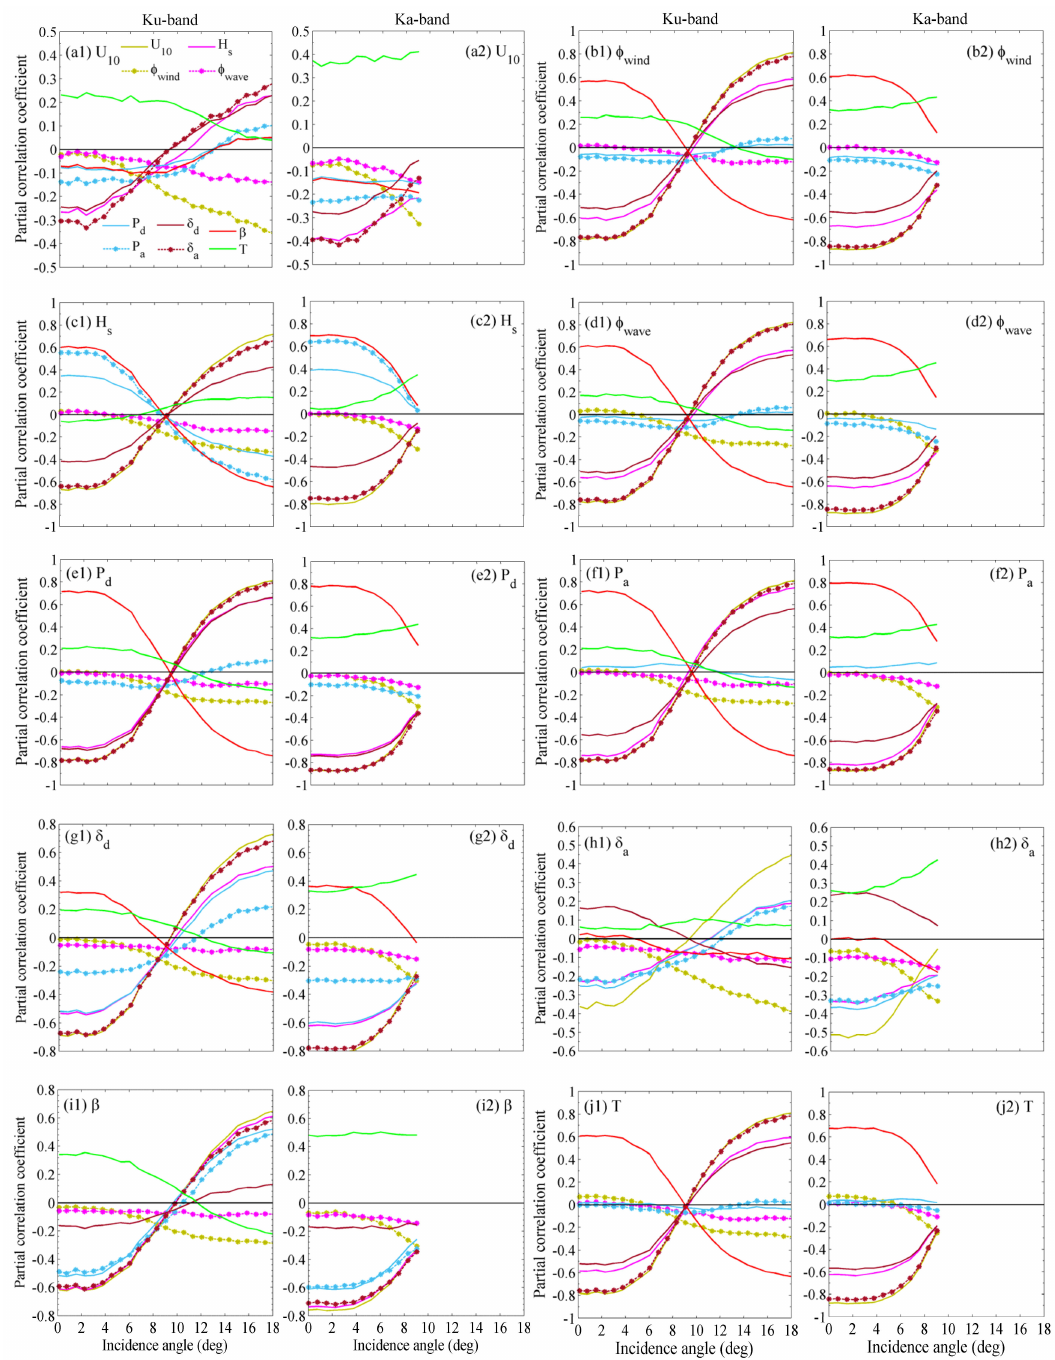
Figure 20. Spearman rank partial correlation coefficients between ( a1-j1 ) KuPR σ 0 , ( a2-j2 ) KaPR σ 0 and various surface parameters, with the control of ( a1 , a2 ) wind speed, ( b1 , b2 ) relative wind direction, ( c1 , c2 ) significant wave height, ( d1 , d2 ) relative wave direction, ( e1 , e2 ) dominant wave period, ( f1 , f2 ) average wave period, ( g1 , g2 ) dominant wave steepness, ( h1 , h2 ) average wave steepness, ( i1 , i2 ) real wave age, ( j1 , j2 ) sea surface temperature, with respect to incidence